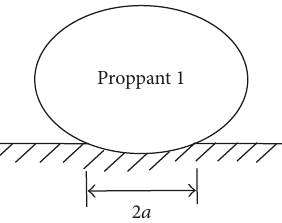
Figure 2: Schematic diagram of proppants